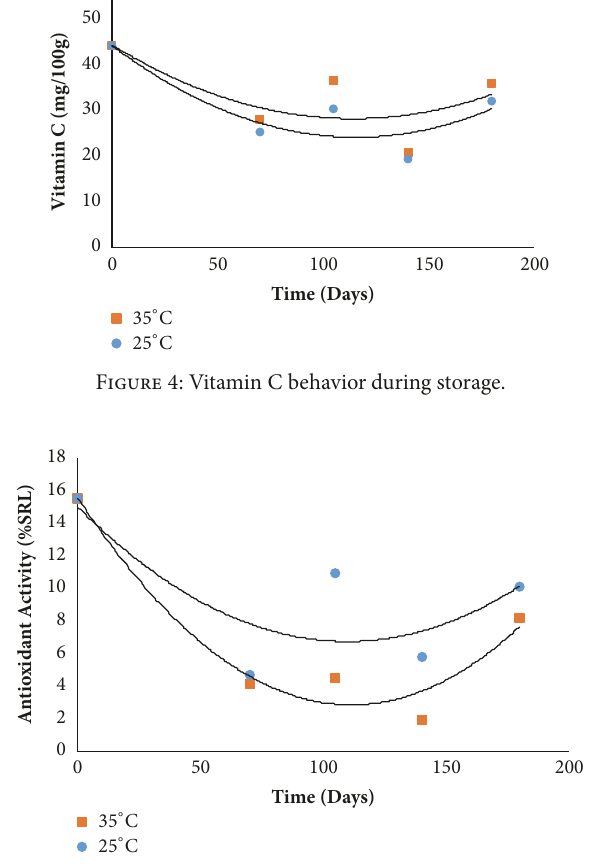
Figure 5: Antioxidant activity behavior during storage.